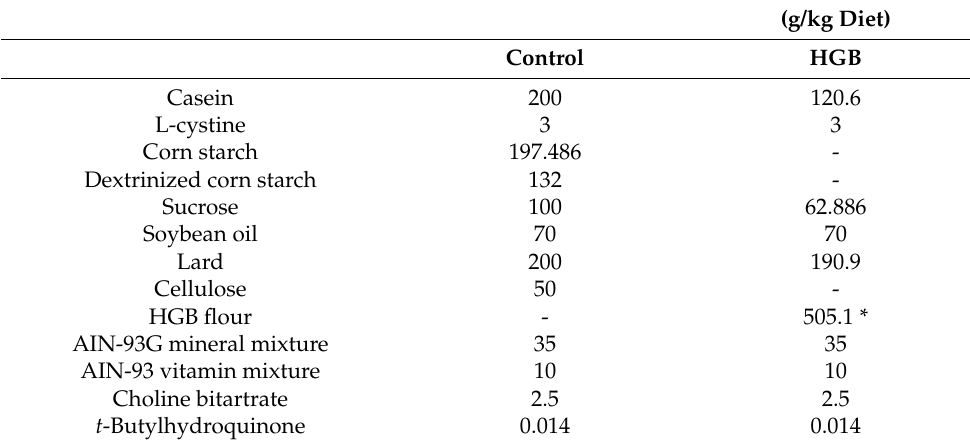
Table 2. Composition of the experimental